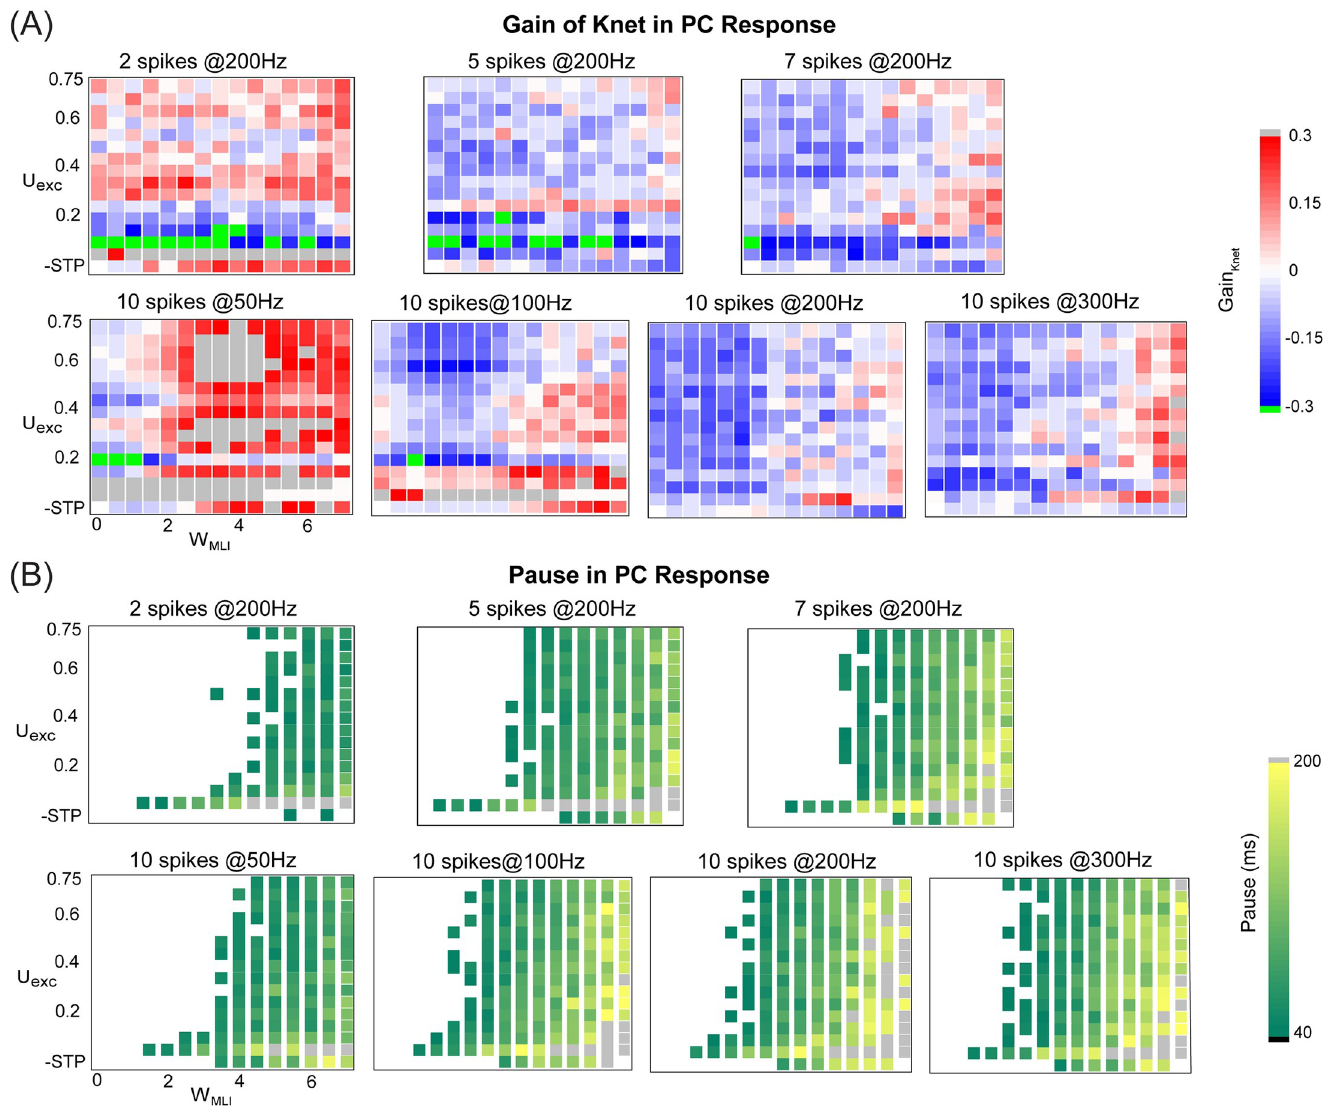
Fig 9. The change of PC synchronization and pause response in the parameter space of excitation and inhibition. (A) The gain of synchronization changed in different ways with W MLI and U exc under bursts with different spikes and frequencies. Each inner rectangle in each panel represents a single gain value of synchronization under one burst protocol. (Top) Bursts with 2, 5 and 7 spikes at 200 Hz. (Bottom) Bursts with 10 spikes at 50, 100, 200 and 300 Hz. In all plots, note that there is no STP but static excitation with U exc = 0.4 in the last row of the matrix. Similarly, there is no MLI inhibition in the first column of the matrix. Thus the first point at the left-bottom corner of the matrix is the baseline. The gain was defined as the relative change calculated by the average K net compared to that in the baseline. (B) Similar to (A) but for pause response induced by